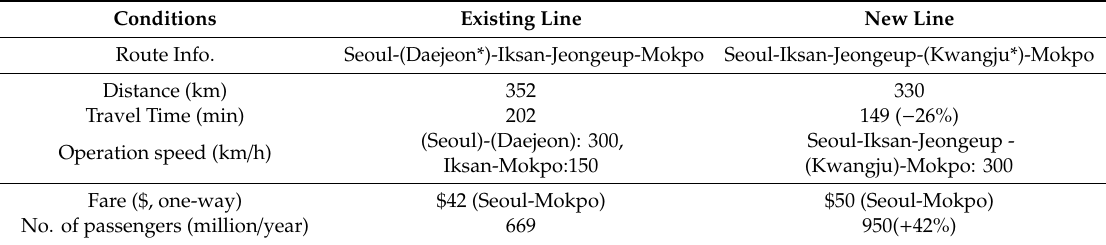
Figure 1. Honam high-speed railway (HSR) line and cities for a case study in Korea. Table 1. Comparison Before and After the Introduction of the Honam HSR line.